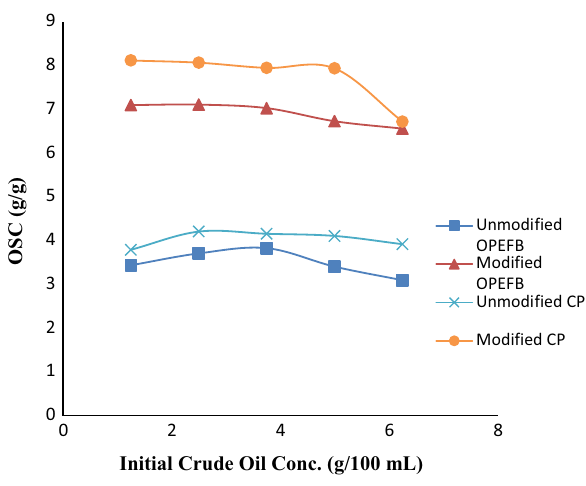
Fig. 5 Effect of initial crude oil concentration on oil sorption capacity (OSC) of the